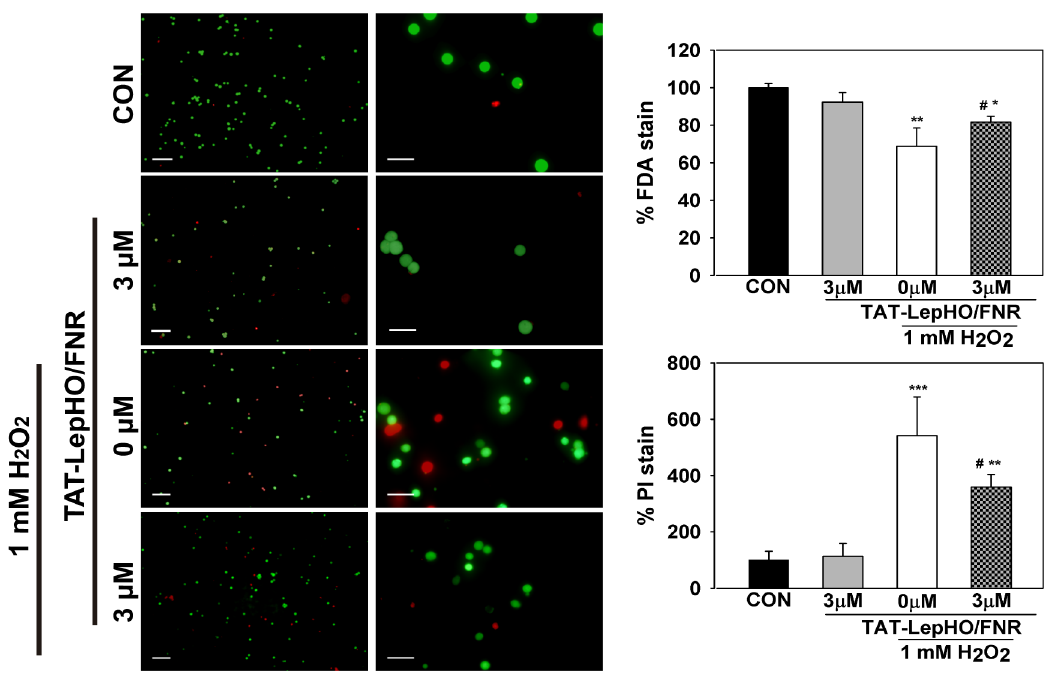
Fig 9. Vital staining FDA/PI showed increased H 2 O 2 tolerance as a result of incubation with TAT-fused proteins. SH-SY5Y cells in suspension (2 x 10 6 ) were simultaneously treated with 3 μ M TAT-LepHO and TAT-LepFNR or left in serum free medium for 1 h and then exposedto 1 mM H 2 O 2 for another hour. Cell pelletswere washedwith PBS buffer and resuspended in 500 μ l of staining medium (serum free DMEM-F12, 2 μ g/mL FluoresceinDiacetate, 1.2 μ g/mL PropidiumIodide). n = 3, quantification was made using cell countingsoftware (ImageJ) on 3 image fields of each independentexperiment. * p < 0.05vs. CON (control) cells; ** p < 0.01vs. CON (control) cells; # p < 0.05vs. H 2 O 2 alone- treated cells. Scale bar first column = 50 μ m; scale bar second column = 20 μ